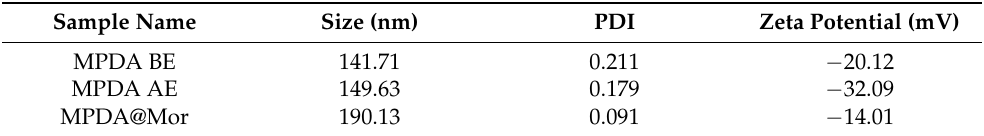
Table 1. The average zeta size, PDI, and zeta potential of samples before template extraction, after extraction, and drug